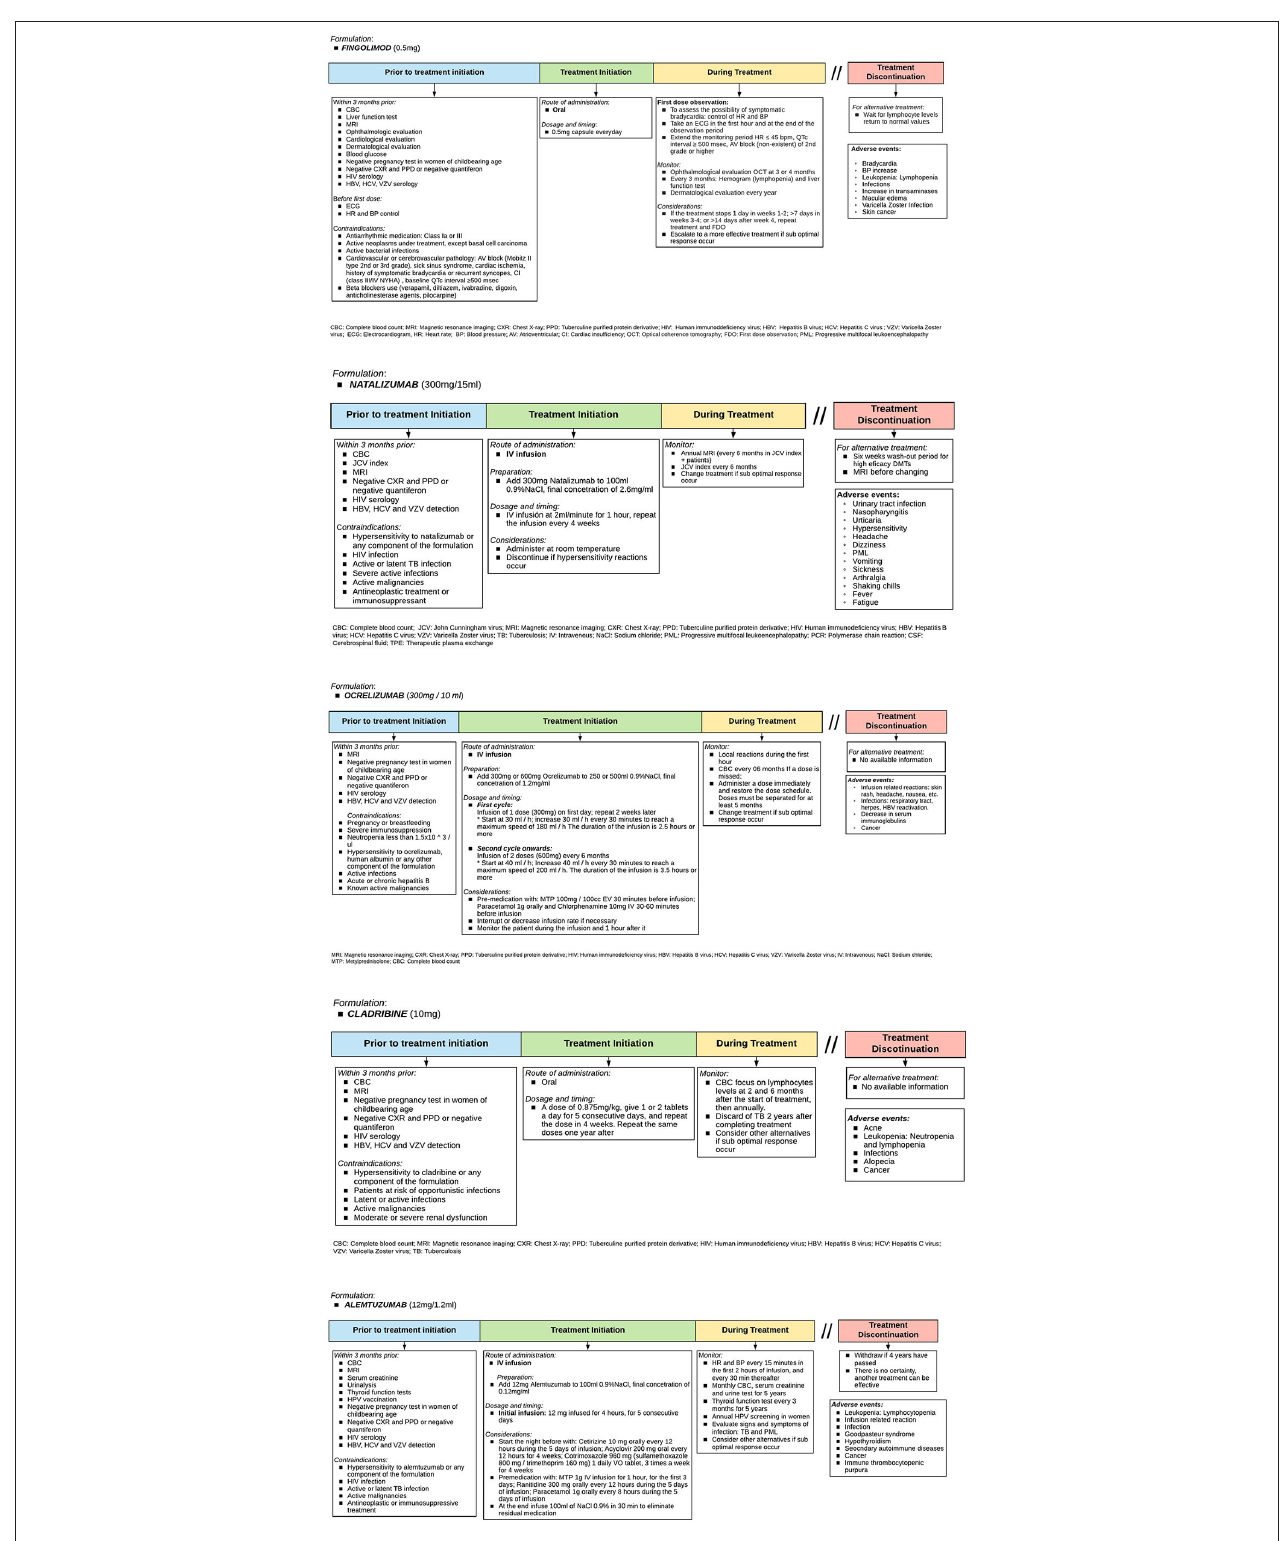
FIGURE 5 | Therapeutic protocol for escalating: Fingolimod, natalizumab, ocrelizumab, cladribine, and alemtuzumab. Adapted from Sorensen et al. (33).